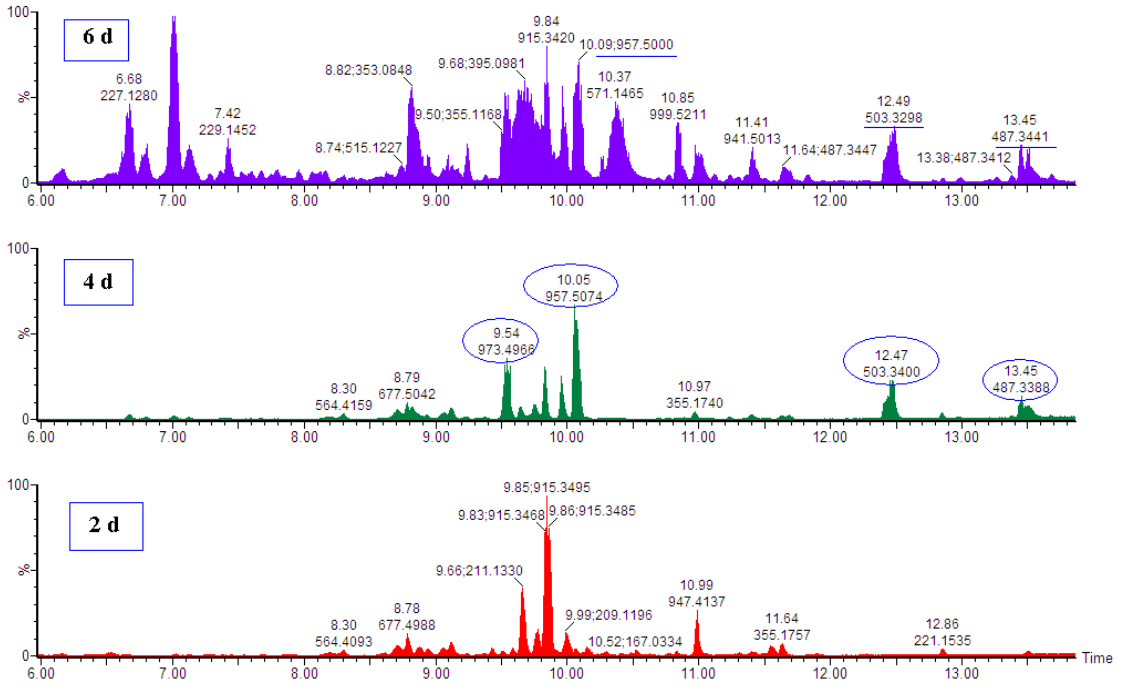
Figure 1. UHPLC-MS (BPI) chromatograms showing treatment-related variations. Ten day old cell suspensions were treated with 0.2 mM MeJa for 2, 4 and 6 days and intracellular metabolites extracted with ethanol. Four ion peaks ( m/z 973.5, 957.5, 503.3 and 487.3) were more predominantly observed in the 4 days samples than in other conditions (2 and 6 days). These ion peaks were further identified as the targeted triterpenoids/centelloids (Table